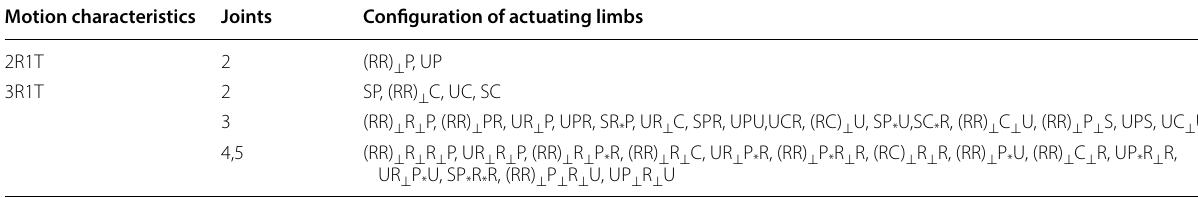
Table 3 Configuration synthesis of the actuating limb Motion characteristics Joints Configuration of actuating